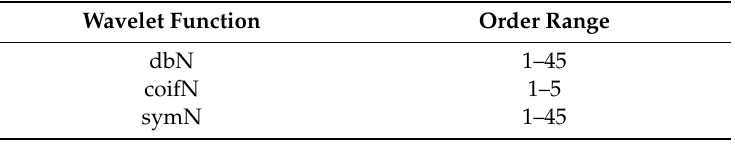
Figure 2. The results of the envelope analysis: ( a ) dbN; ( b ) coifN; ( c ) symN.